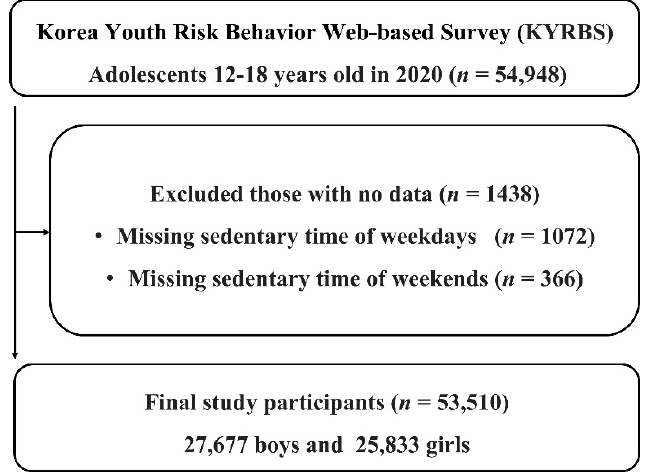
Figure 1. A flow diagram of the study participants.